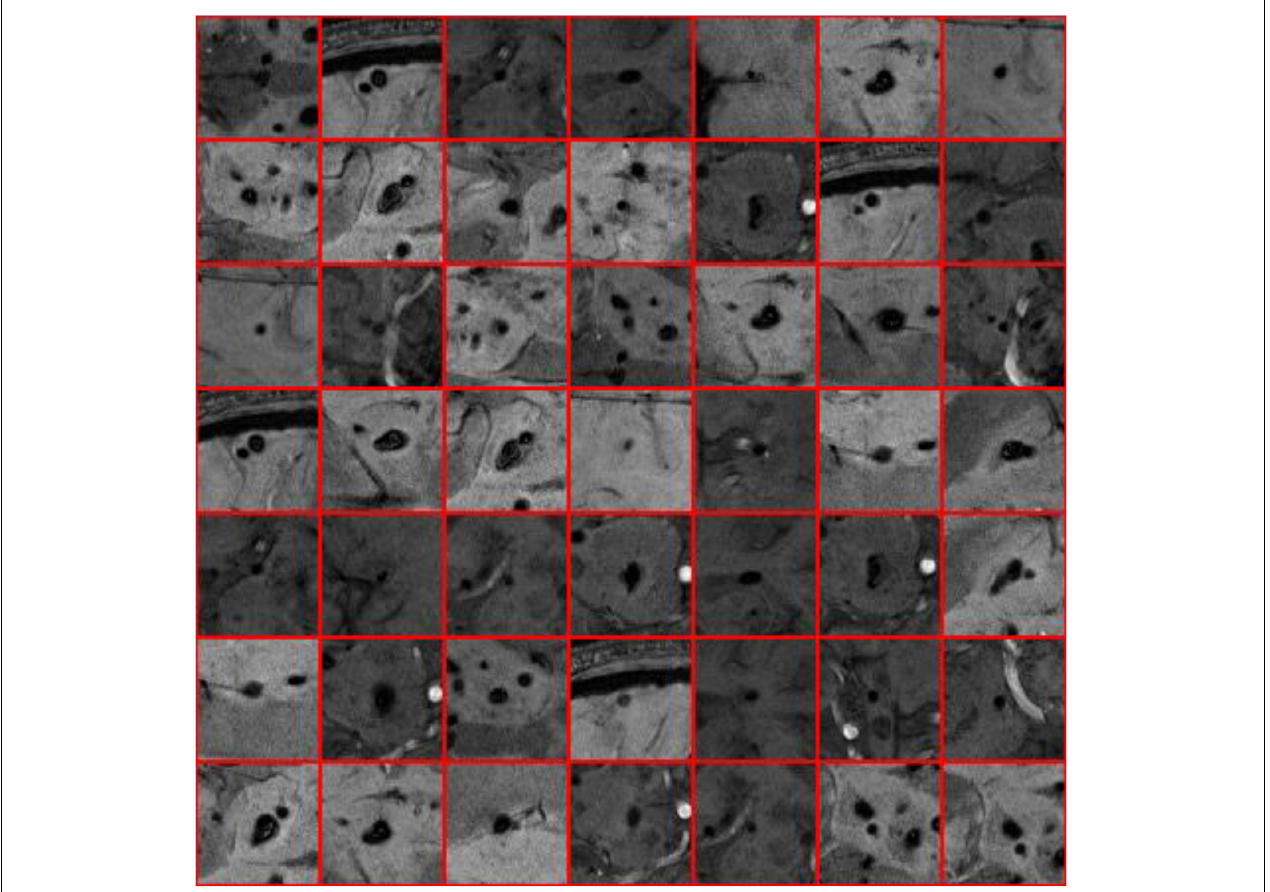
FIGURE 5 | CMB samples.